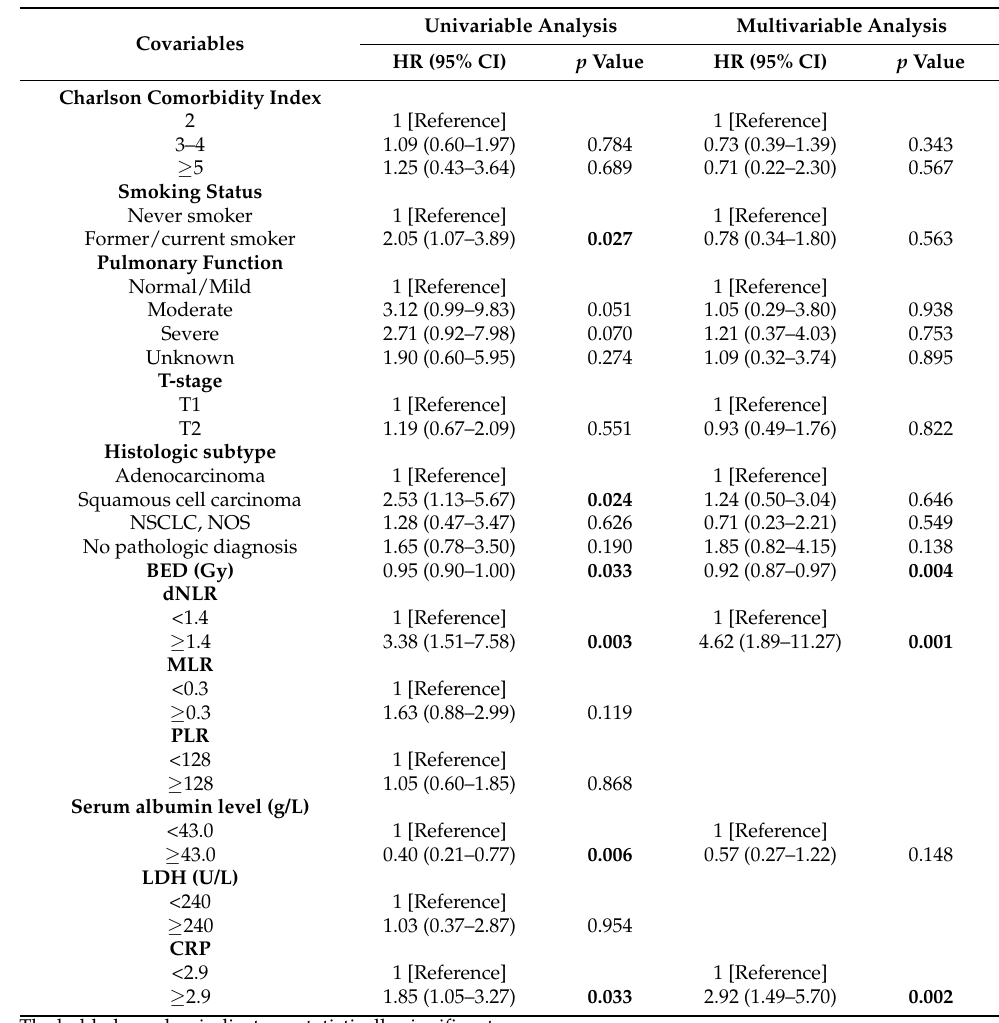
The bolded number indicates a statistically significant.